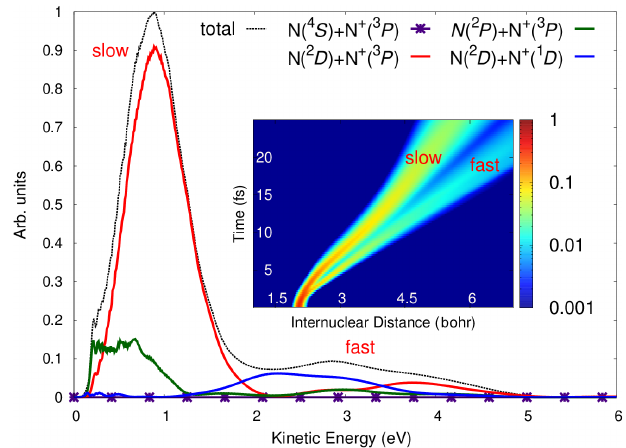
FIG. 4. Theoretical N þ kinetic energy spectrum (black dashed line) and the partial contributions of groups of states leading to the different dissociation channels (in increasing order of energy of the dissociative limit: magenta, red, green, blue). The inset shows the time evolution of the initial wave packet ultimately resulting in the given kinetic energy